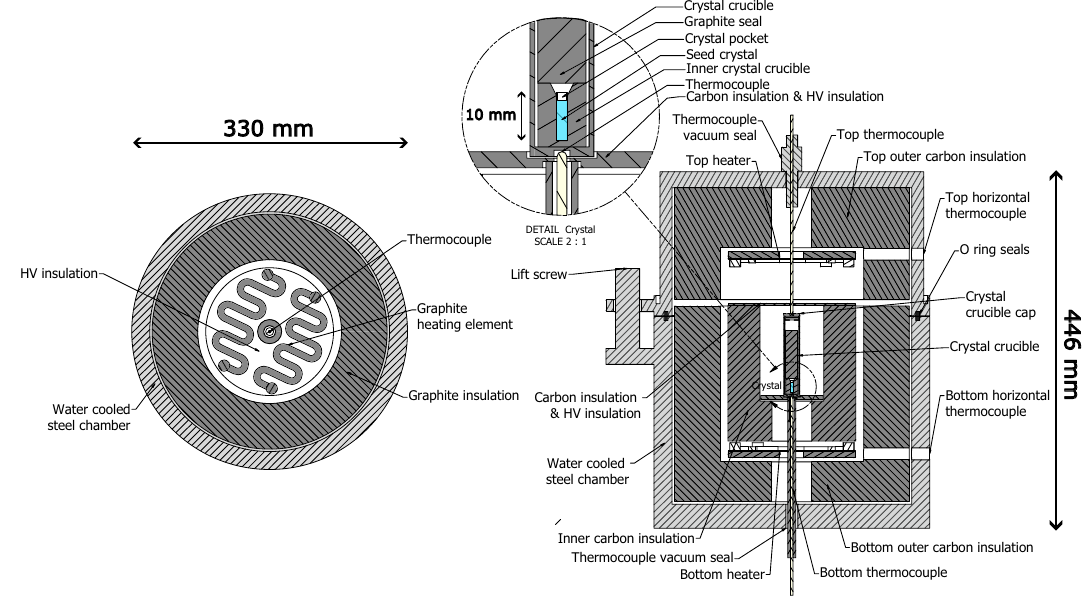
Figure 8. Crystal growing device used to grow 3.2 mm diameter crystals. On the left side is a horizontal cut displaying the graphite heating element with the isolated thermocouple through the center. The right image displays a vertical cut that shows all of the main components of the vertical gradient freeze growing apparatus and zooms into the crystal